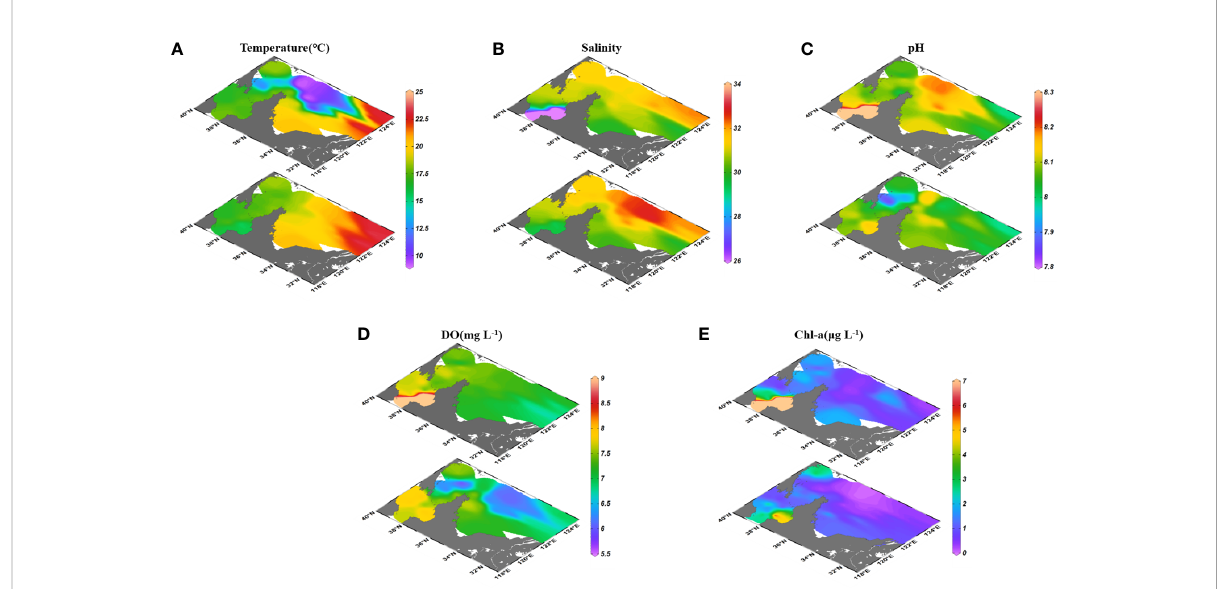
FIGURE 3 Distributions of hydrochemical parameters temperature (A) , salinity (B) , pH (C) , DO (D) and Chl- a (E) in surface and bottom seawaters of the BS and